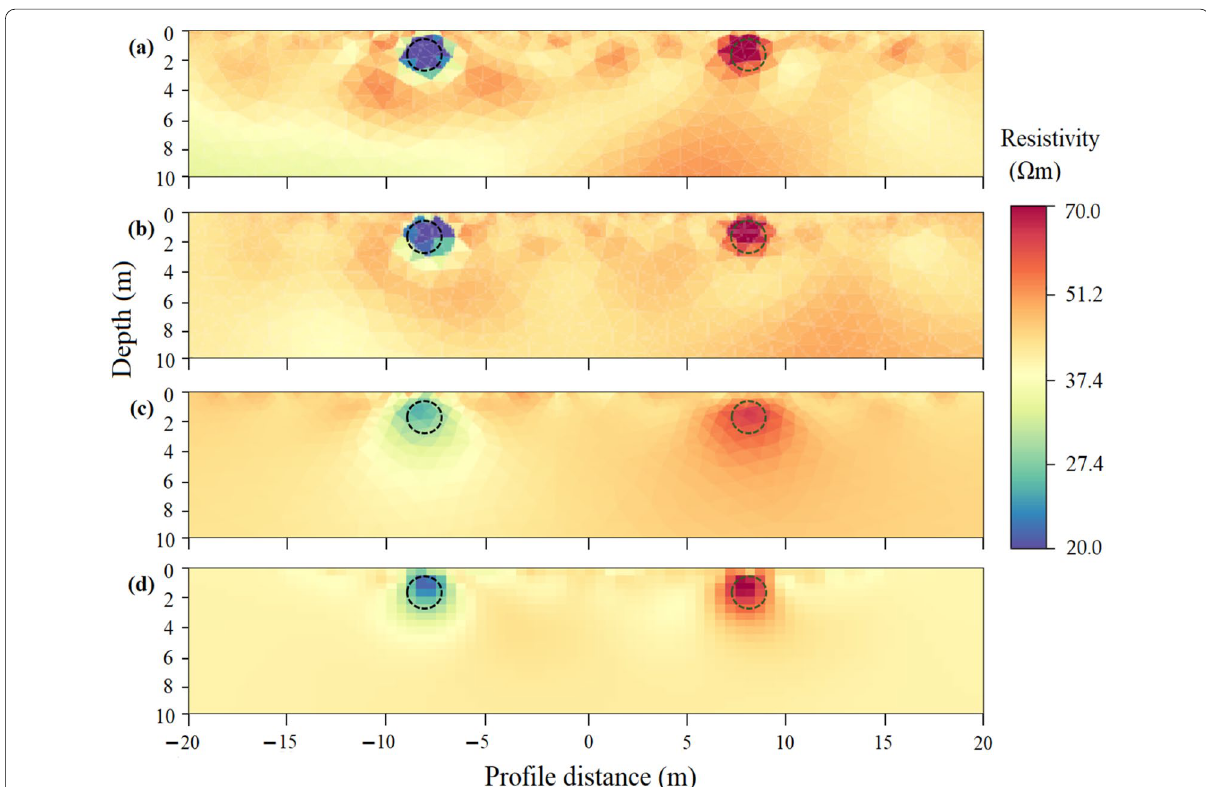
Fig. 9 The inverted model of scenario one for a 1 m target radius located at 1.5 m depth using the inversion freeware: a pyGIMLi, b BERT, c ResIPy, and d SimPEG. The broken circles indicate the actual targets; the left for conductive while the right for resistive target. Unstructured triangular mesh is implemented in pyGIMLi, BERT, and ResIPy, whereas tensor mesh is used in